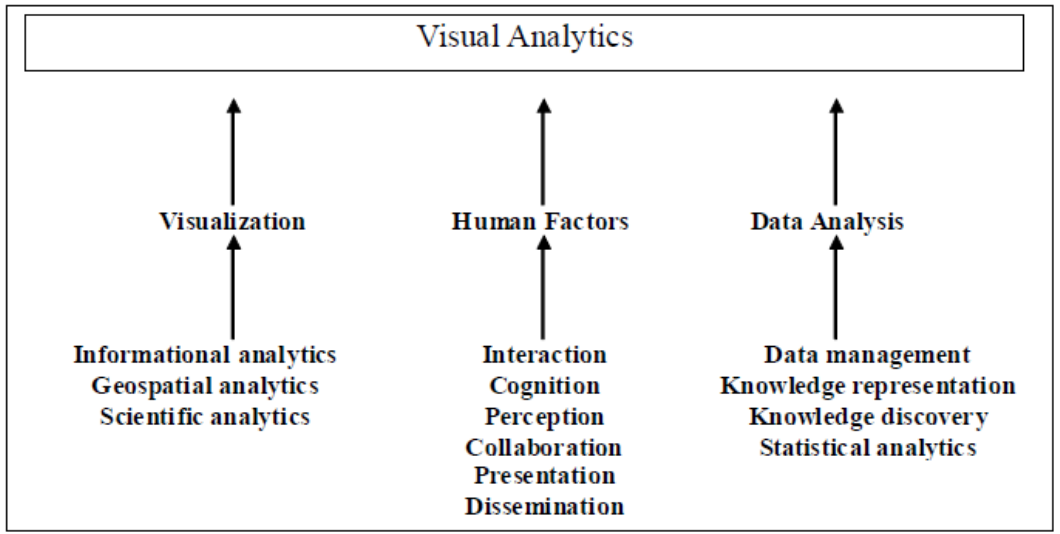
Figure 1. Visual Analytics as an integrated